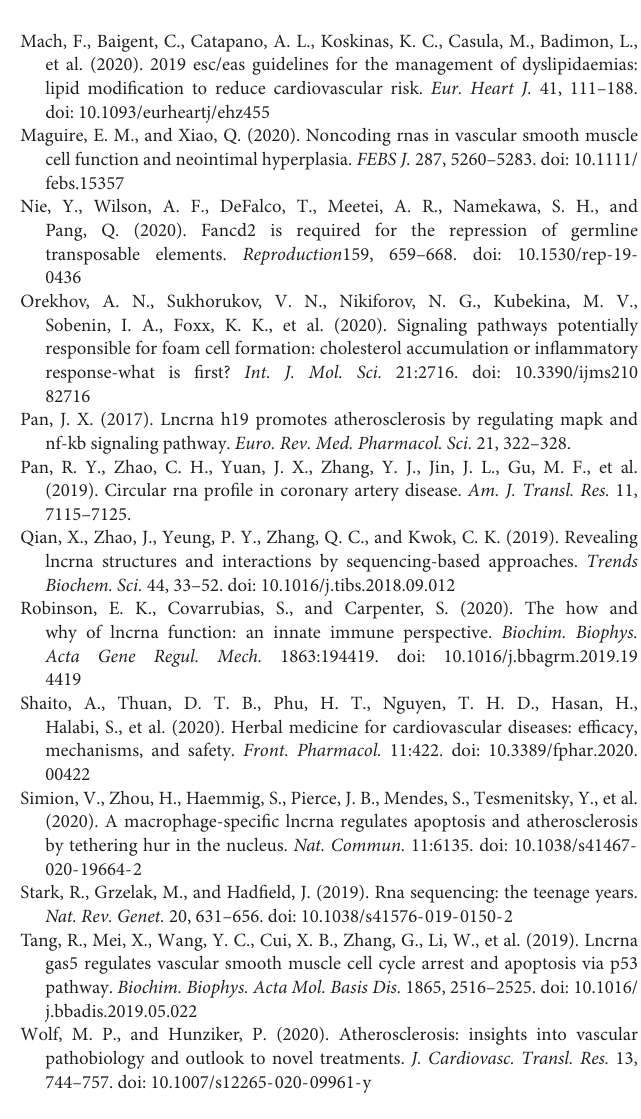
Supplementary Figure 1 | Proliferation and migration of HCASMCs were induced by ox-LDL. (A) CCK-8 assay showed the proliferative ability and a marked increase in the viability of HCASMCs after stimulation with ox-LDL at 0, 25, 50, 75, and 100 mg/L. ** p < 0.01, *** p < 0.001. (B) Cell cycle analysis of HCASMCs stimulated with ox-LDL at 50 mg/L for 24 h. * p < 0.05. (C) Wound healing assay showing quantification of the residual wounded area at 24 h postscratch vs. controls ( n = 5). *** p < 0.001. (D) Transwell assays were also used to examine cell migration, and quantitative statistical analysis of cell migration data is presented as the means ± SDs from five samples. *** p <